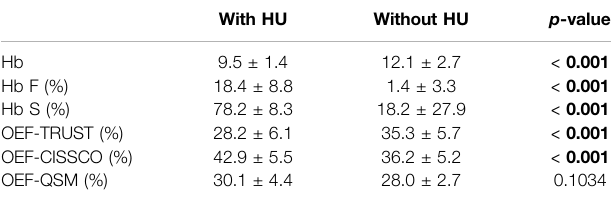
TABLE 2 | Differences between hemoglobin F, hemoglobin S and OEF by three methods with or without hydroxyurea (HU) for non-transfused SCD patients. With HU Without HU